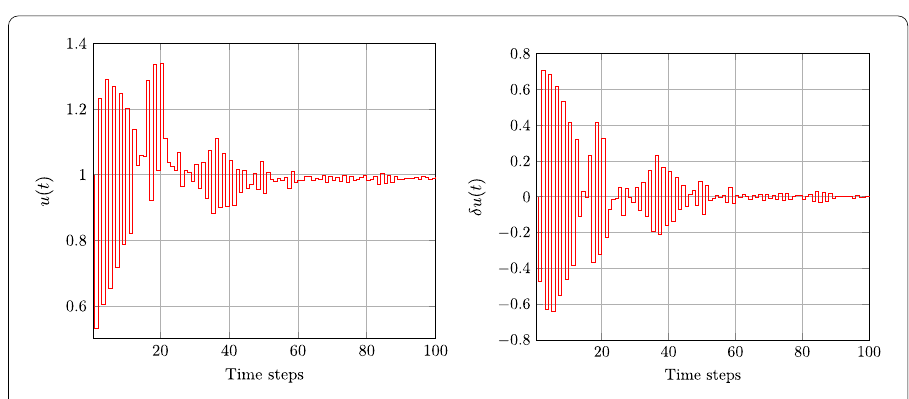
Fig. 26 Evolution of the command variable (left) and its incremental corrections (right) along the controlled welding process- Case